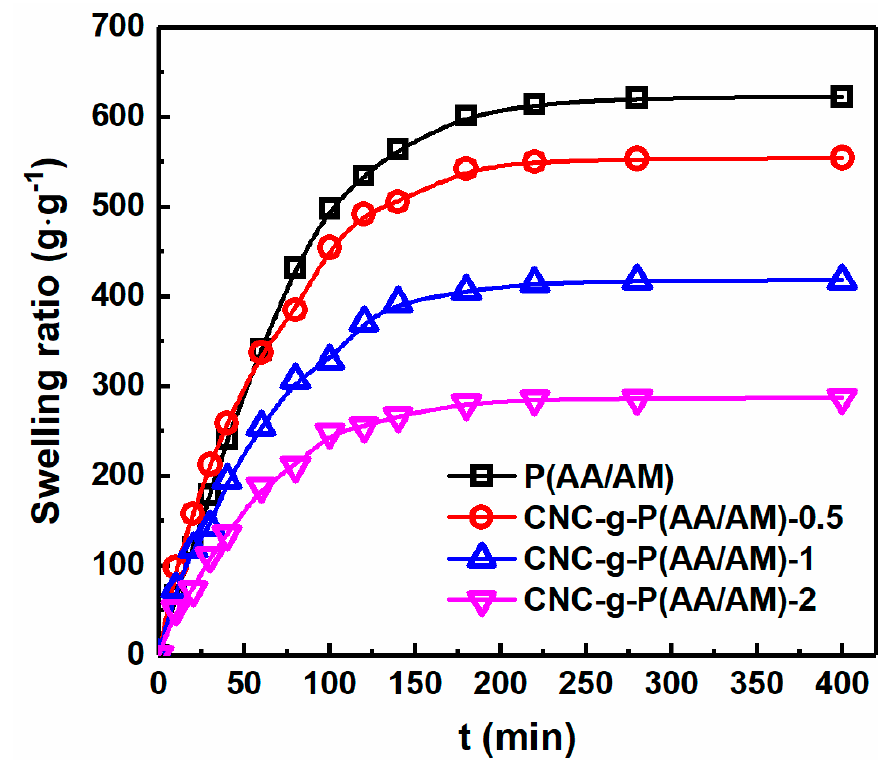
Figure 4. Swelling ratios of P(AA/AM), CNC-g-P(AA/AM)-0.5, CNC-g-P(AA/AM)-1, and CNC-g-P(AA/AM)-2.